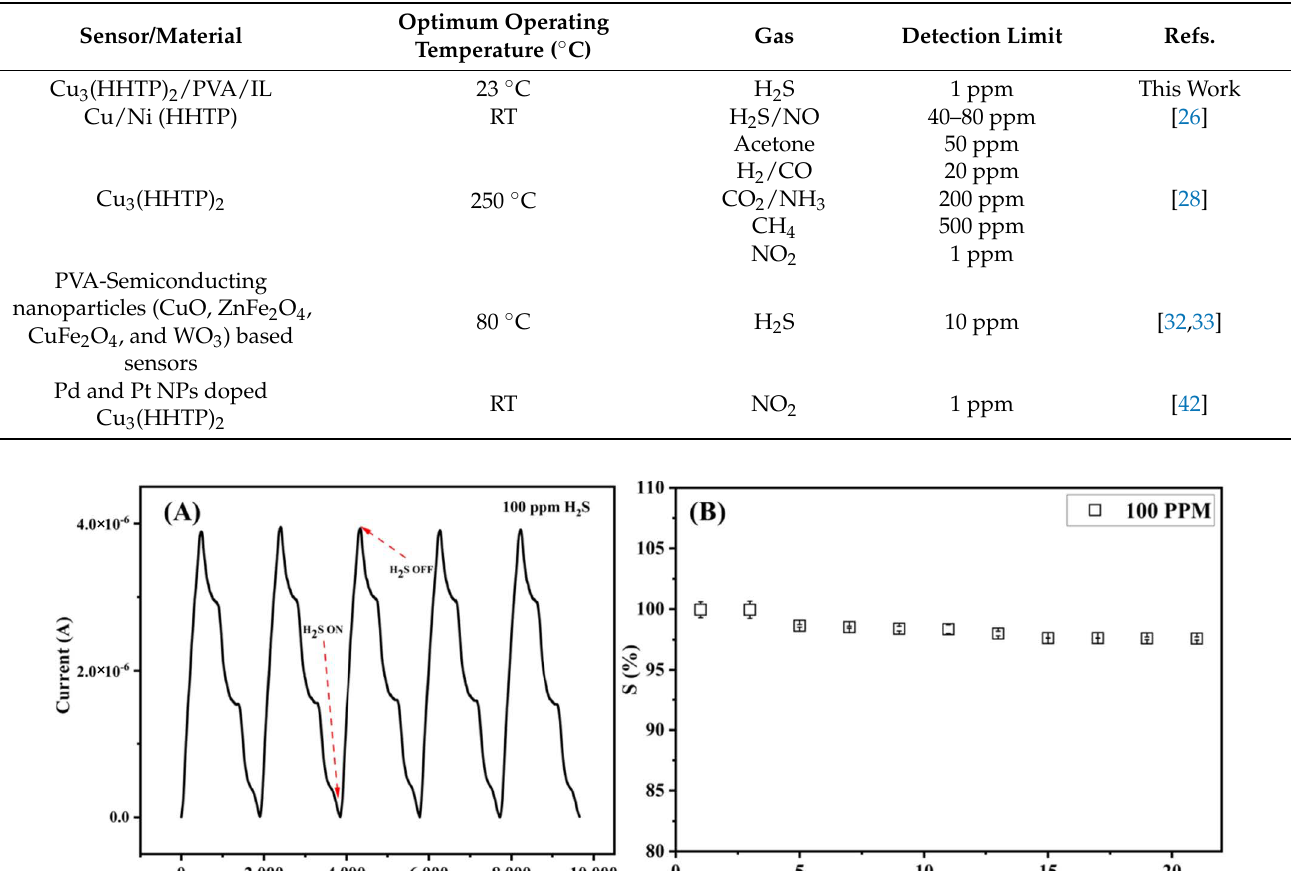
Table 1. Sensor performance comparison with literature-reported values.